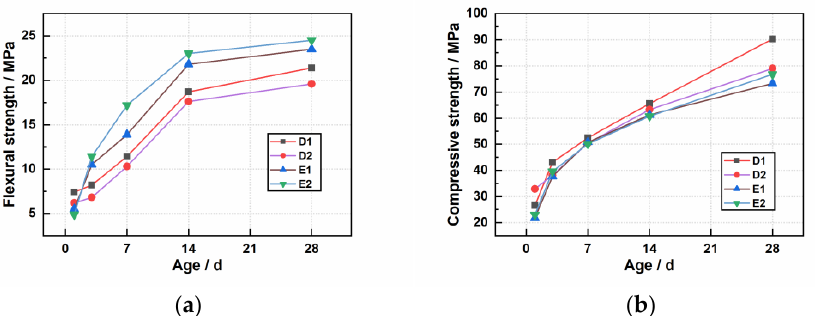
Figure 3. The effect of modified fibers of the material on the strength: ( a ) flexural strength; ( b ) compressive strength.